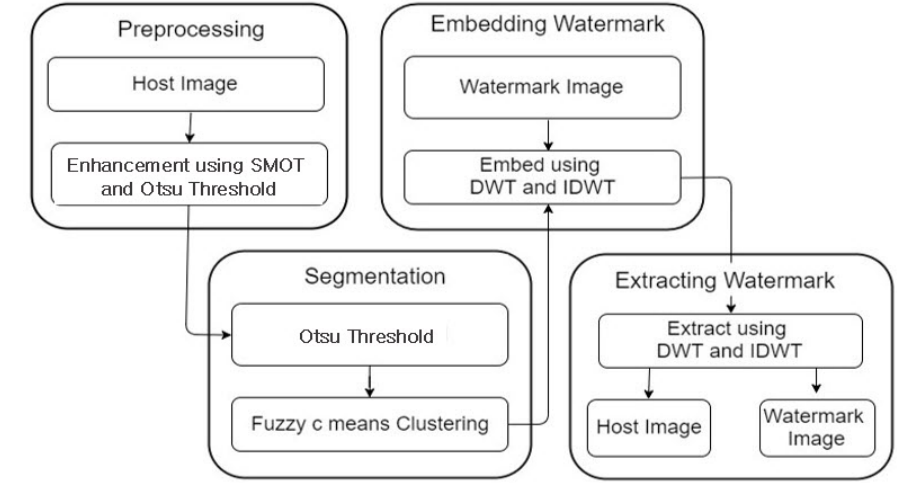
Figure 1. Flowchart of the proposed model.